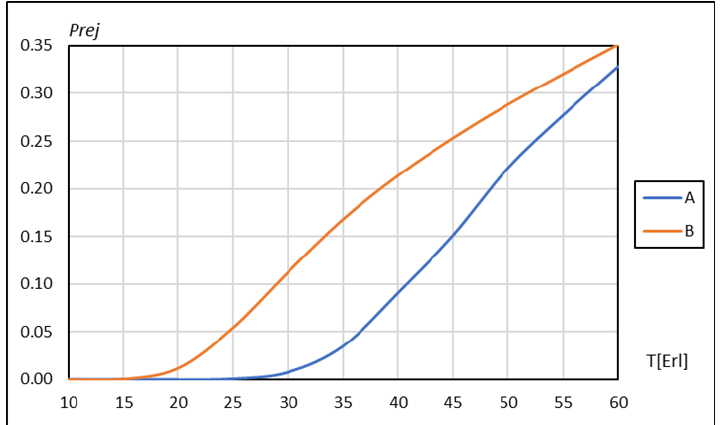
Figure 2. Results of simulating the probability of rejecting a call in the function of traffic density for graphs A and B (Figure 1). P rej —probability of rejecting the call for realization, T —density of the generated traffic measured in